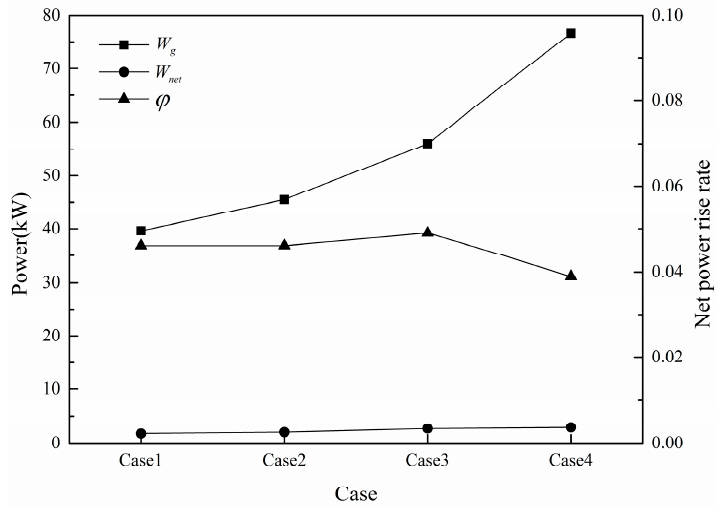
Figure 6. Net power rise rate.